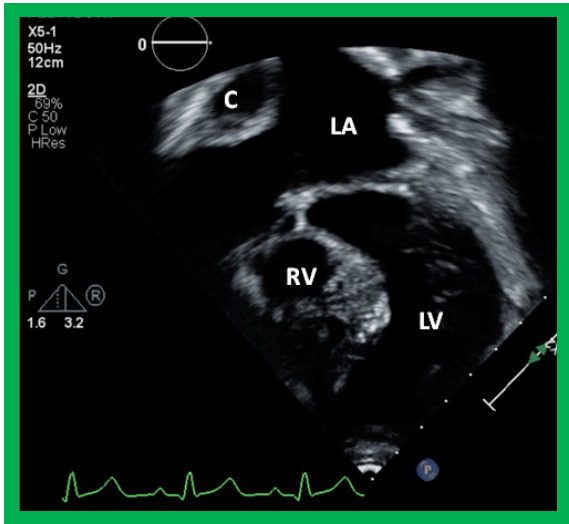
Figure 44. Selected video frame from an apical four-chamber view demonstrating the left ventricle (LV) and hypoplastic right ventricle (RV) in a patient who had a Fontan procedure. Note that the RV protrudes into the left ventricular (LV) outflow tract. Cross-sectional view of the conduit (C) is also shown. LA, left atrium.